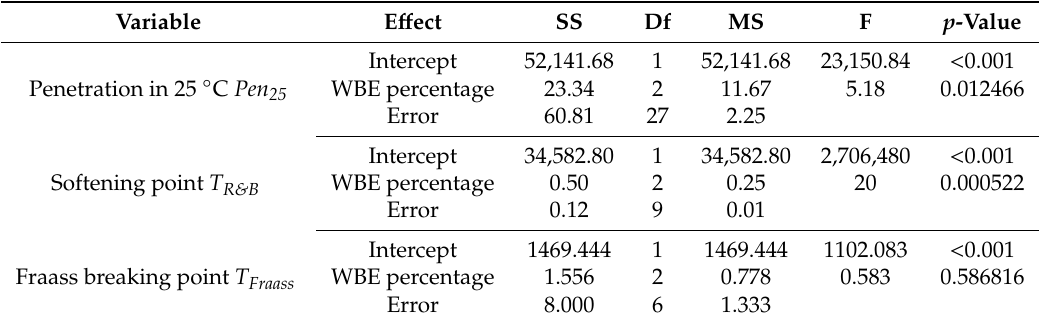
Table 9. Results of analysis of variance (one-way ANOVA) assessing the e ff ects of WBE content on the basic properties of the tested bituminous binders.